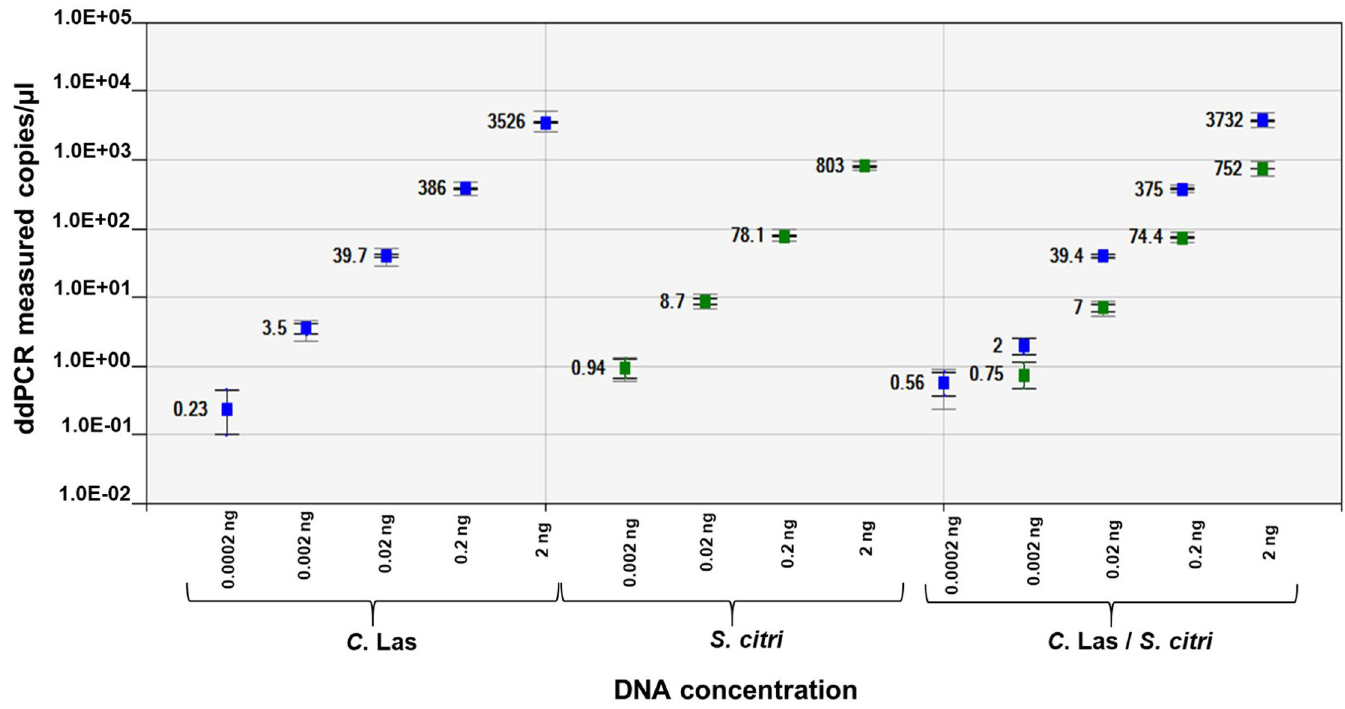
Fig 6. Linear regression of the singleplex and duplex ddPCR assays for detection of “ Candidatus Liberibacter asiaticus” (RNR gene) and Spiroplasma citri (ORF1 gene) in dually infected citrus leaf DNA. The Pearson correlation coefficient of singleplex RNR and ORF 1 DNA regression curve is 0.999 and 1, respectively. Pearson correlation coefficient of duplex RNR and ORF1 DNA regression curve is 1. The inner error bars indicate the Poisson 95% confidence interval (CI) and the outer error bars show the total 95% CI of replicates. (P < 0.0001).